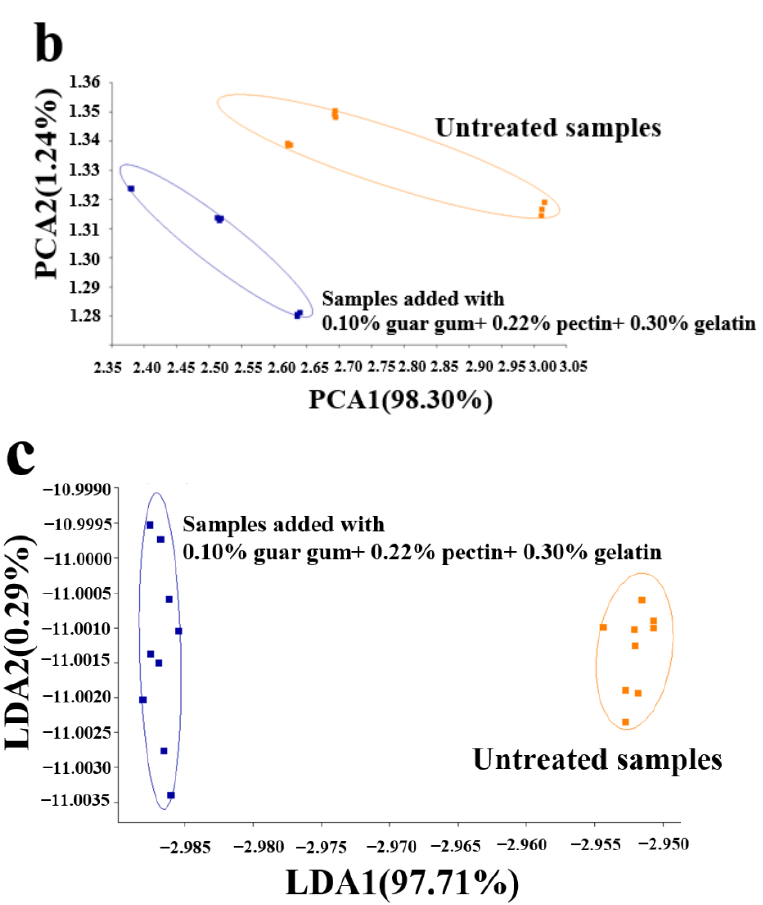
Figure 4. The radar map ( a ), principal component analysis ( b ), and linear discriminant analysis ( c ) of volatile compounds of untreated and treatment samples of the freeze-dried restructured strawberry blocks. Note: “W1C”means “aromatic, benzene”; “W3S” means “sensitive to long-chain alkanes”;